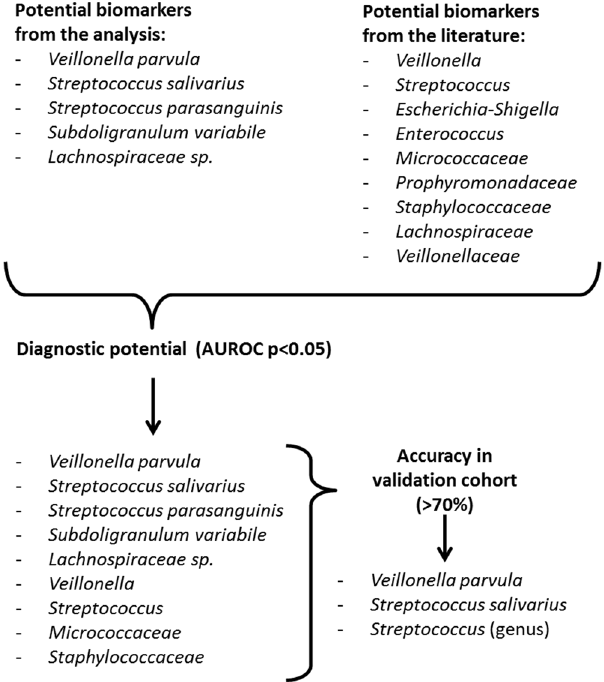
Figure 2. Workflow for biomarker identification.